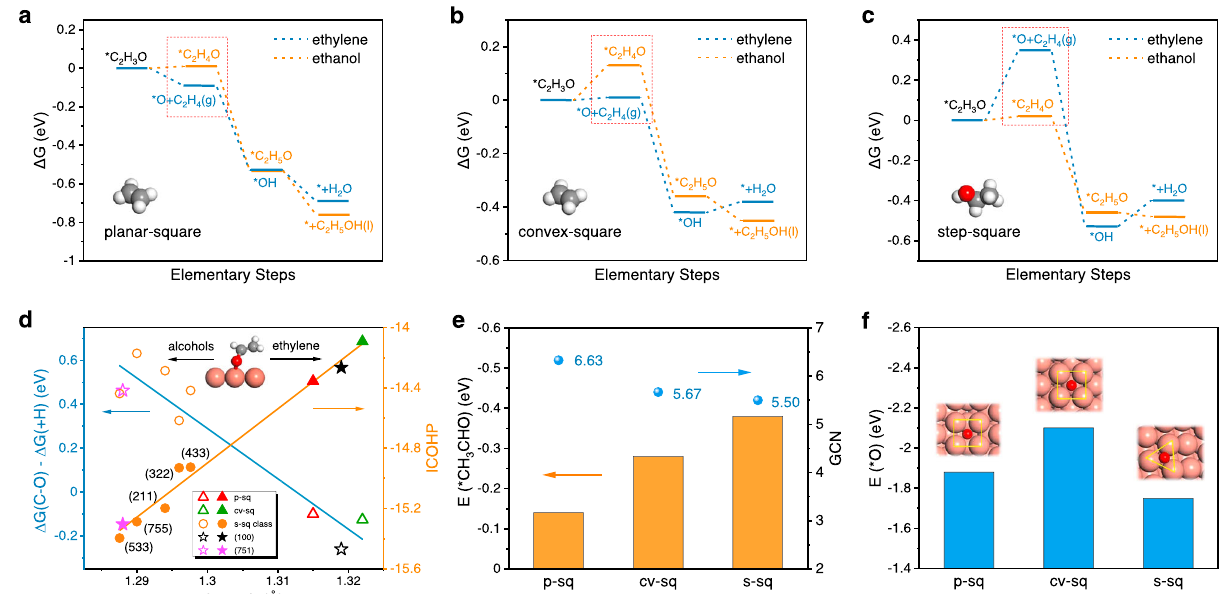
Fig. 3 Identi fi cation of product-speci fi c active sites. Energy pro fi le to form ethylene (blue line) and ethanol (orange line) for a planar-square site, b convex-square site, and c step-square site. d Blue: The relationship between the bond length of C – O in adsorbed CH 2 CHO and the difference of Gibbs-free reaction energy of C – O scission ( Δ G(C – O)) and hydrogenation ( Δ G( + H)). Orange: The relationship between the bond length of C – O in adsorbed CH 2 CHO and the ICOHP of C – O bond. e General coordination number and adsorption energy of *CH 3 CHO on these three active sites. f Adsorption energy of *O on these three active